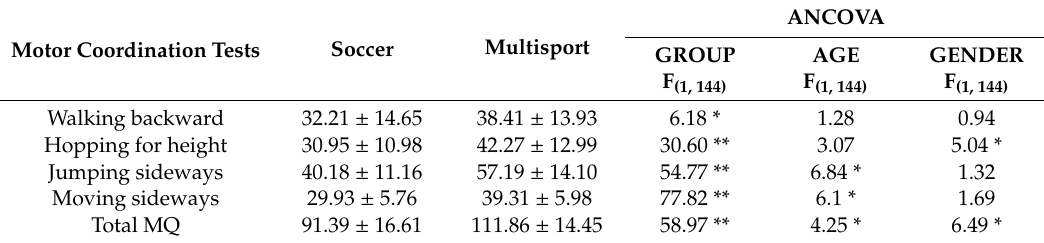
Table 2. Results of motor coordination tests in children engaged in soccer and multisport.